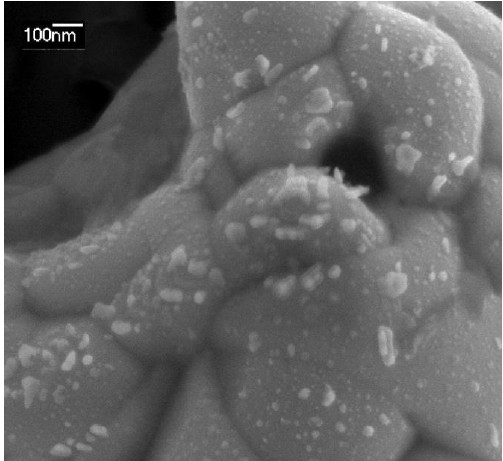
Figure 3. SEM image of AgNPs synthesized by the galvanostatic multipulse method